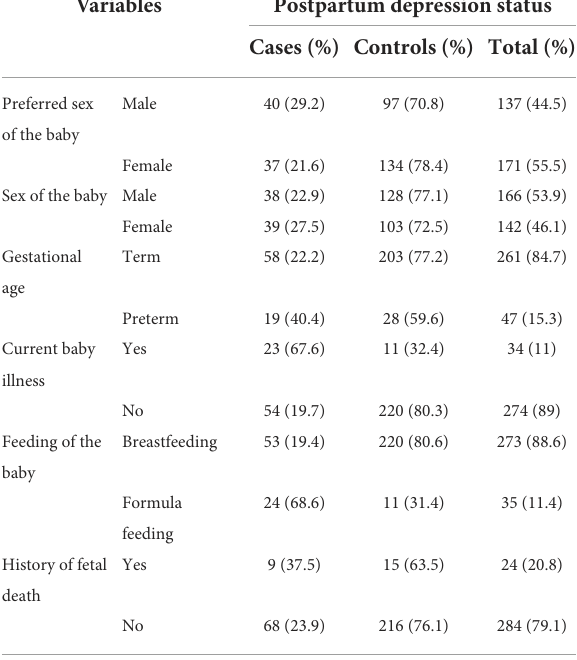
TABLE 3 Newborn-related factors of respondents by depression category in Debre Tabor Town.